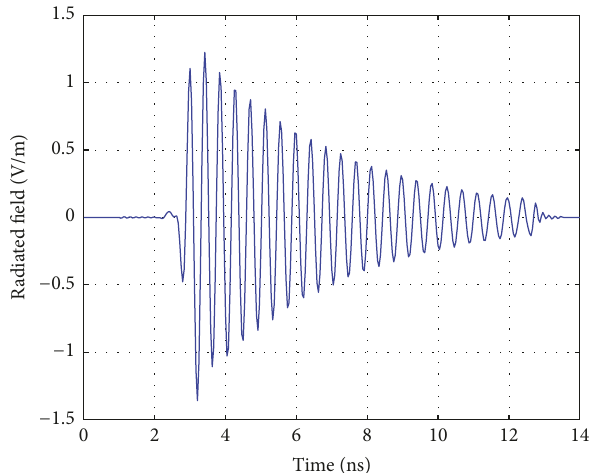
Figure 18: Impulse response of the single band microstrip antenna.